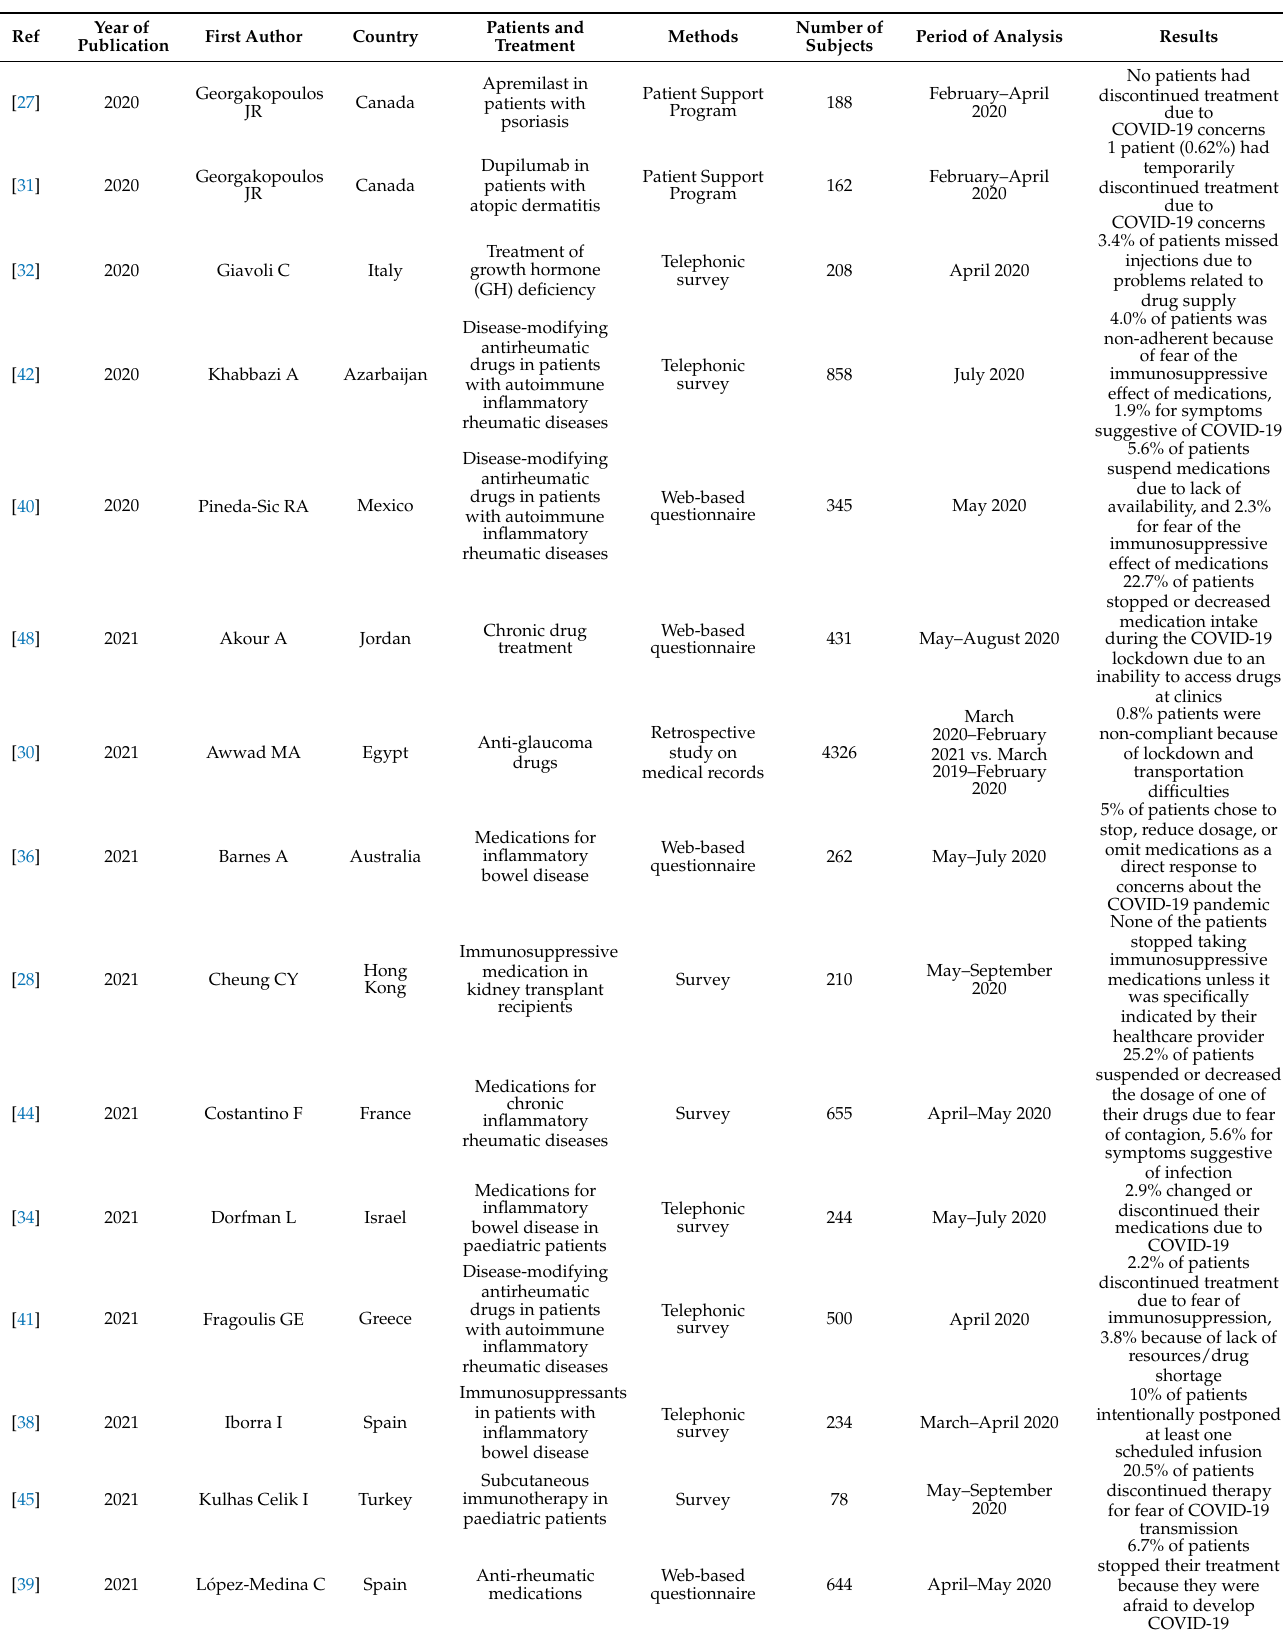
Table 2. Summary of included studies (n = 24) reporting the rate of treatment discontinuation/delay specifically due to factors linked to COVID-19 (secondary